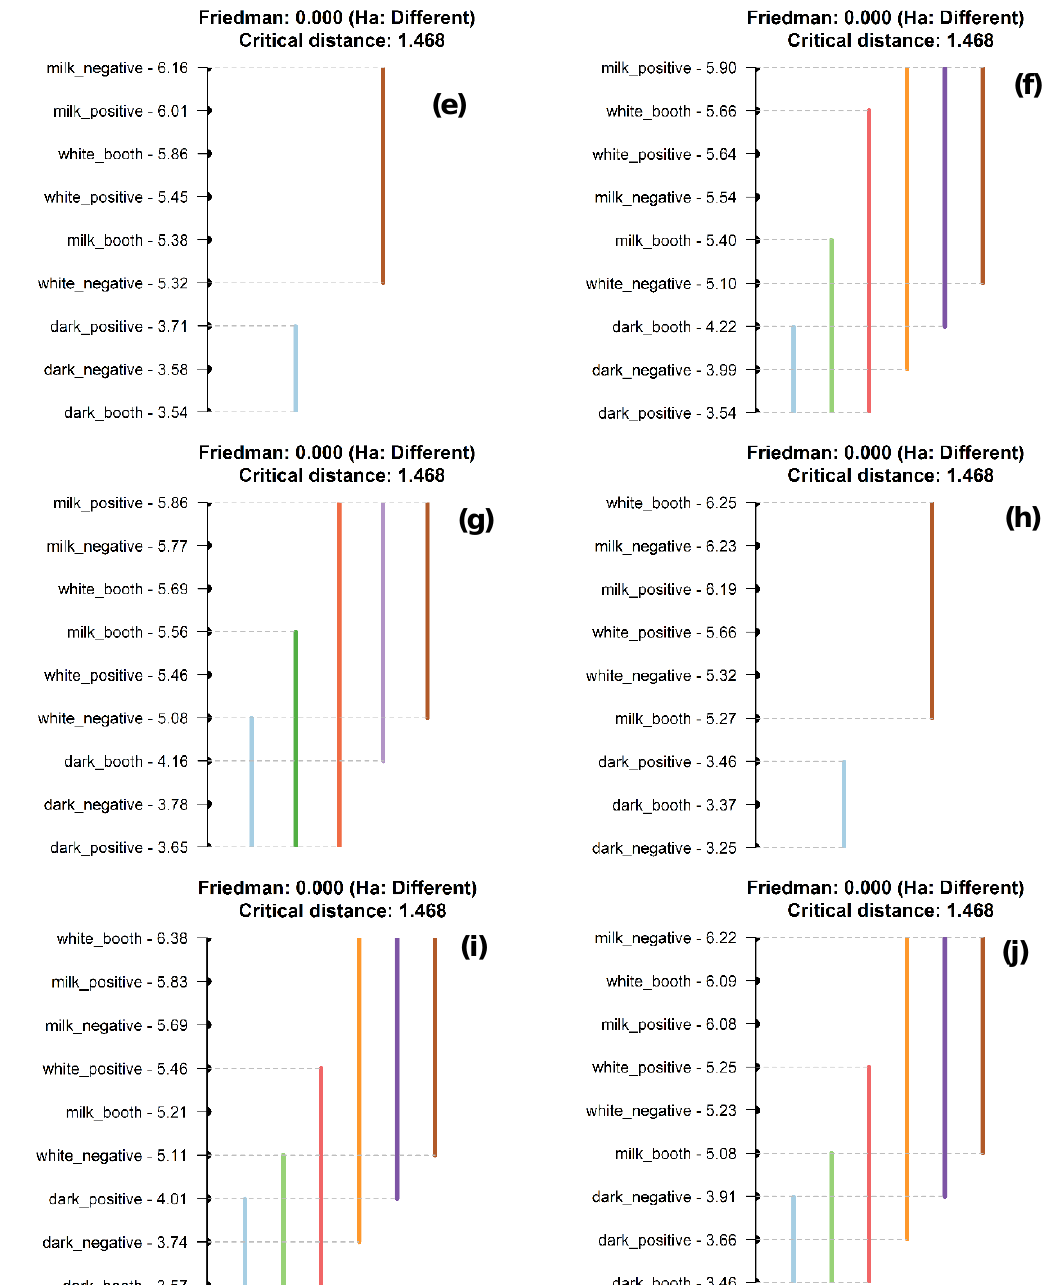
Figure 2. Nemenyi test (post hoc) results comparing medians at 5% significance level for sensory attributes, ( a ) taste, ( b ) sweetness, ( c ) bitterness, ( d ) cocoa flavor, ( e ) dairy flavor, ( f ) texture, ( g ) hardness, ( h ) smoothness, ( i ) aftertaste, and ( j ) overall. Treatments sharing color implies not statistically different.